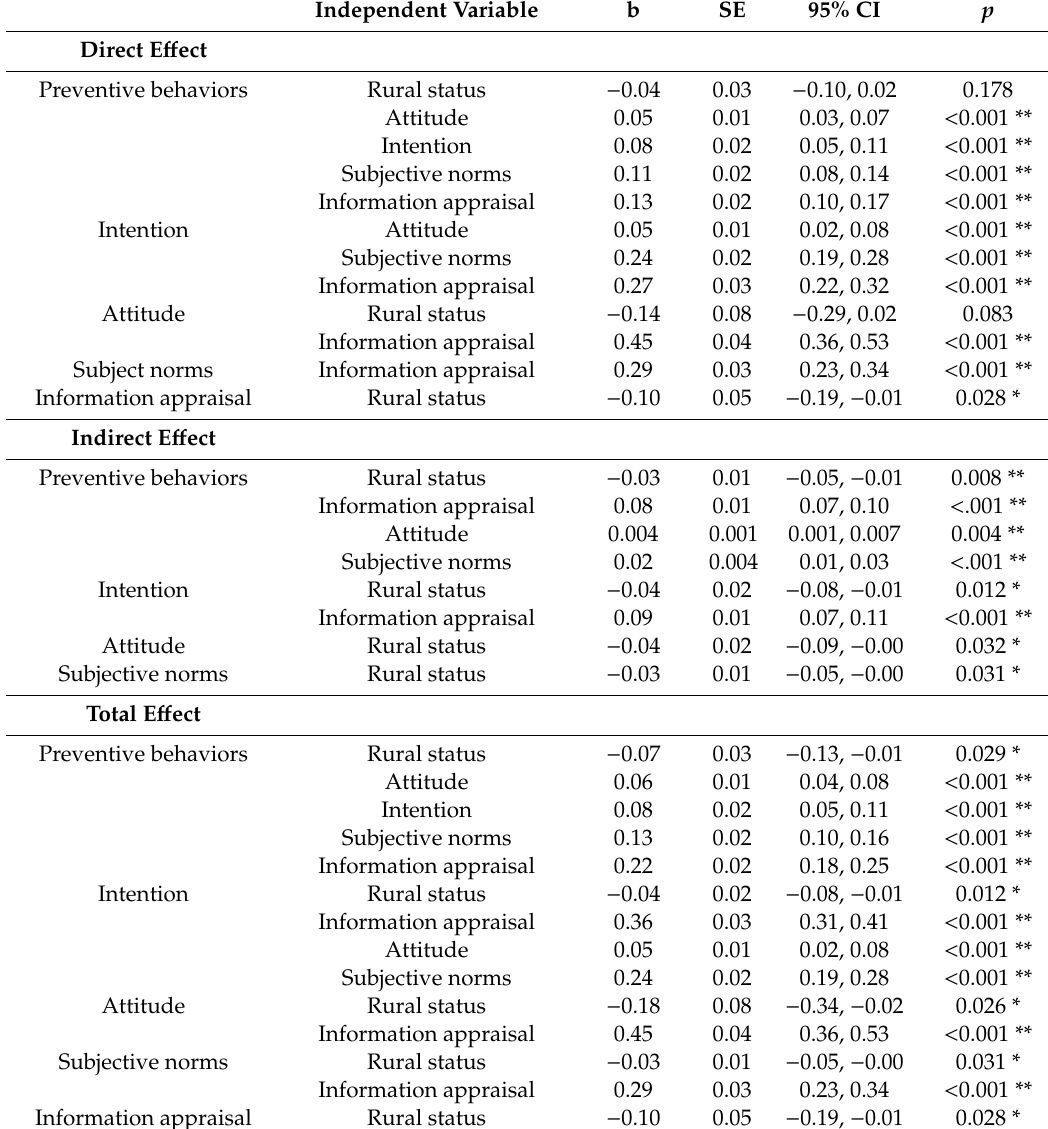
Table 2. Path analysis